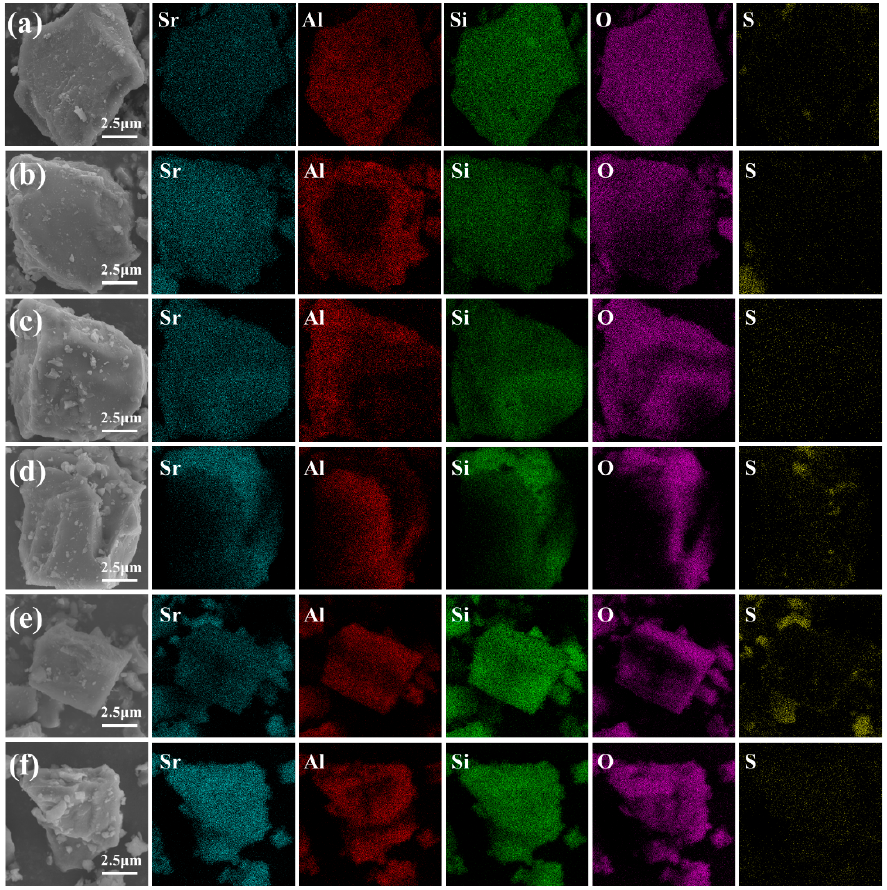
Figure 6. Elemental distribution of the sintered samples: ( a ) 1100 °C, 20 w t.% SrSO 4 , ( b ) 1200 °C, 20 w t.% SrSO 4 , ( c ) 1300 °C, 20 w t.% SrSO 4 , ( d ) 1100 °C, 30 w t.% SrSO 4 , ( e ) 1200 °C, 30 w t.% SrSO 4 , and ( f ) 1300 °C, 30 w t.% SrSO 4 .